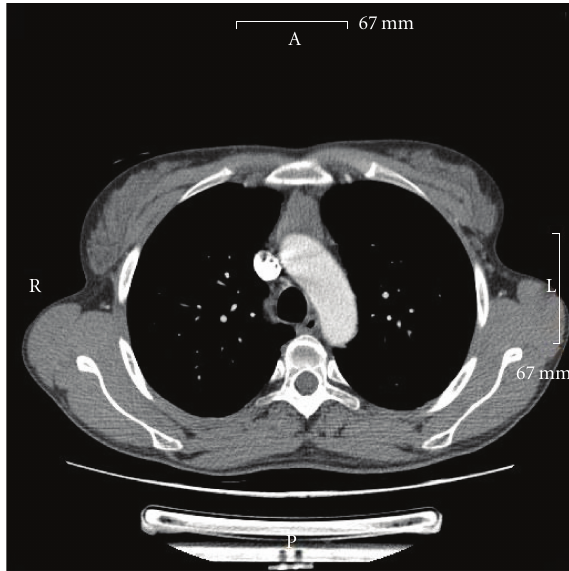
Figure 1: CT scan of the thorax showing the enlarged mediastinal mass in front of the aortic